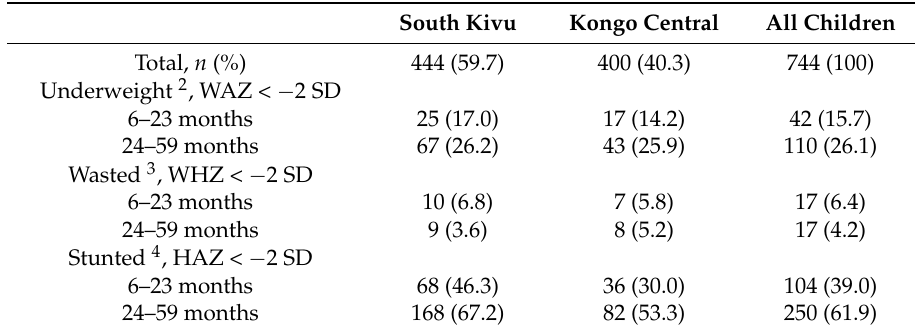
Table 6. Proportion of children 6–23 and 24–59 months ( n = 702) as underweight, wasted, stunted, and with low mid-upper arm circumference by province 1 . South Kivu Kongo Central All Children Total, n (%) 444